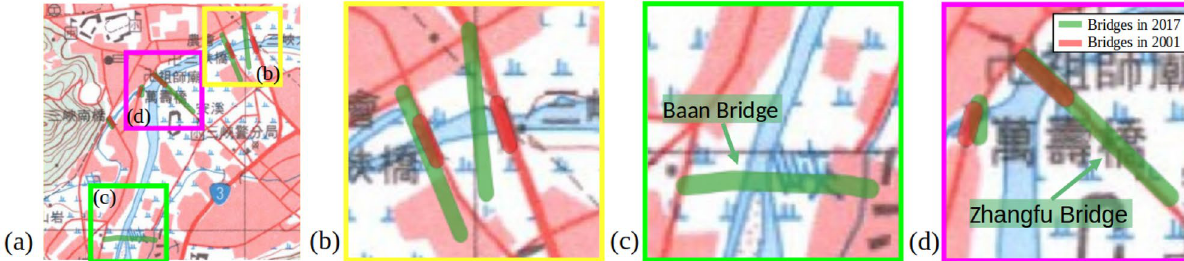
Figure 3. An example of misalignment of geographic features between a contemporary map and a historical map. In ( a ), an example map tile published in 2001 shows some possible misalignment between bridges in contemporary vector data (green strokes) and on historical maps (red strokes), and ( b ), ( c ), and ( d ) are subregions in ( a ) to emphasize the misalignments. In ( b ) bridges had changed greatly by 2001, while in ( c